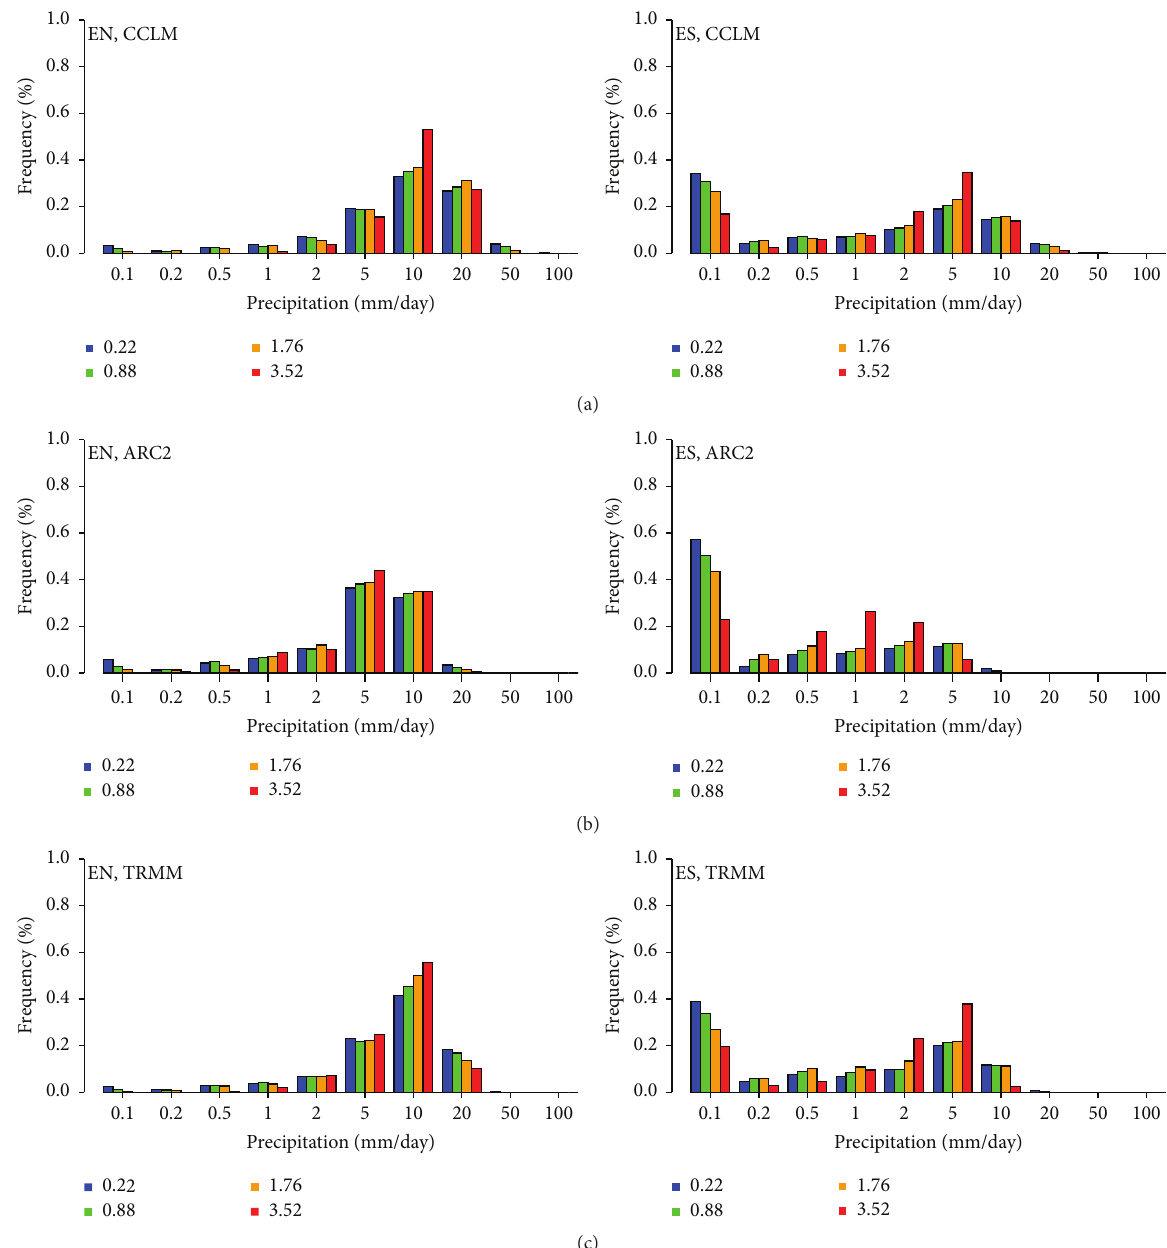
Figure 8: Frequency distribution of daily precipitation for COSMO-CLM (top), ARC2 (middle), and TRMM (bottom) over multiscale resolution for North Ethiopia (EN, left) and South Ethiopia (ES, right). Coloured bars show the different spatial resolutions.